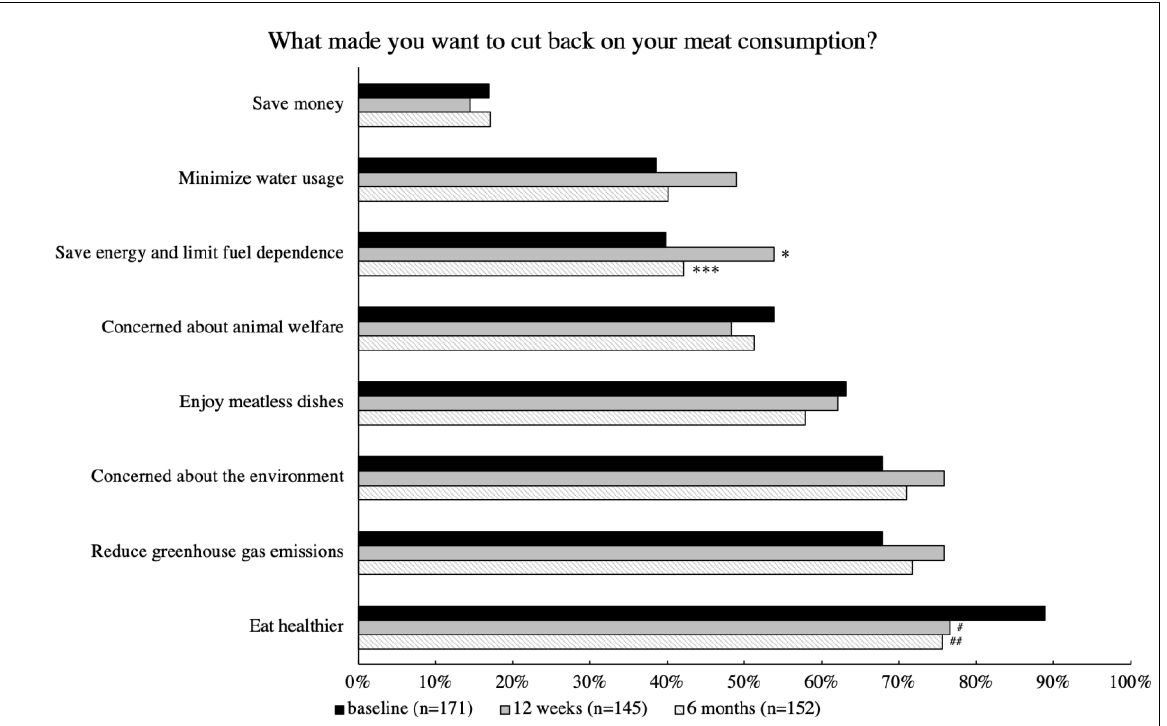
Figure 3. Meat Reduction Rationales at Baseline, 12 Weeks, and Six-Month Follow Up